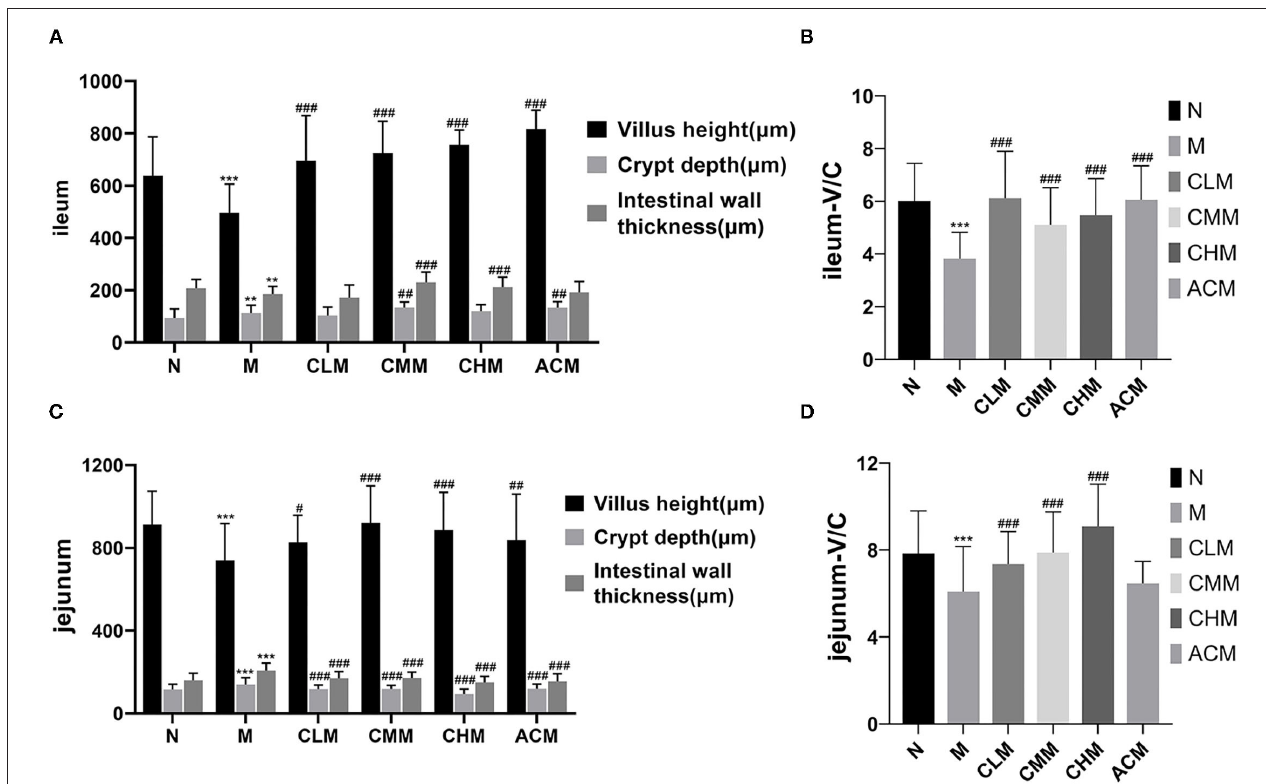
FIGURE 8 | Effects of CSP on villus height, crypt depth and wall thickness of ileum (A) , V/C ratio of ileum (B) , villus height, crypt depth and wall thickness of jejunum (C) and V/C ratio of jejunum (D) in chicken intestine. Data are expressed as mean ± SD. ** p < 0.01, and *** p < 0.001 compared with N group; # p < 0.05, ## p < 0.01, and ### p < 0.001 compared with M